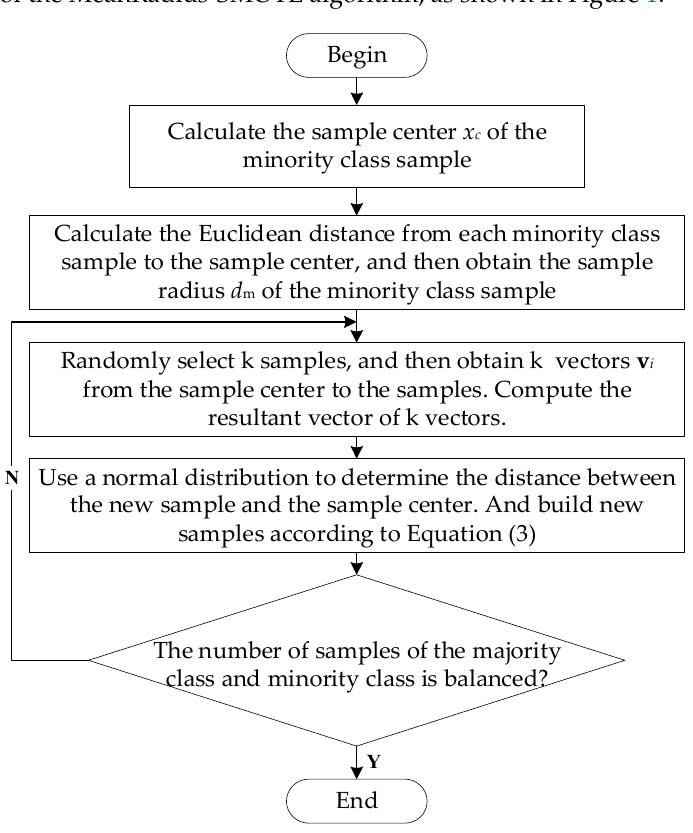
Figure 1. The flow chart of the MeanRadius-SMOTE algorithm. In the MeanRadius-SMOTE algorithm, k and θ are hyperparameters of the algorithm, which are determined according to the number of minority class samples and the imbalance rate. If k is too large, the direction of the new sample relative to the sample center will become meaningless, and θ directly affects the distribution of the new sample. As shown in Figure 2, new samples under different θ are likely to be distributed in colored areas. When θ is too small, the new sample may be far from the sample center. When θ is too large, the new sample is too conservative and cannot balance the number of positive